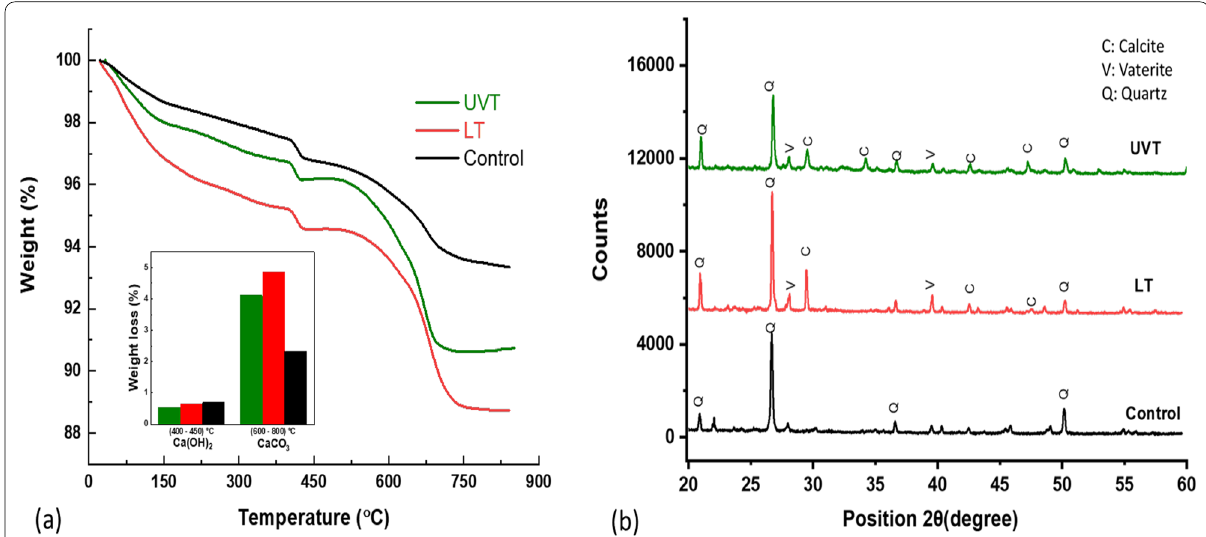
Fig. 7 TGA ( a ), and XRD pattern ( b ) of mortar specimens treated with live (LT) and UV treated (UVT) Synechocystis pevalekii cells at 28-day of